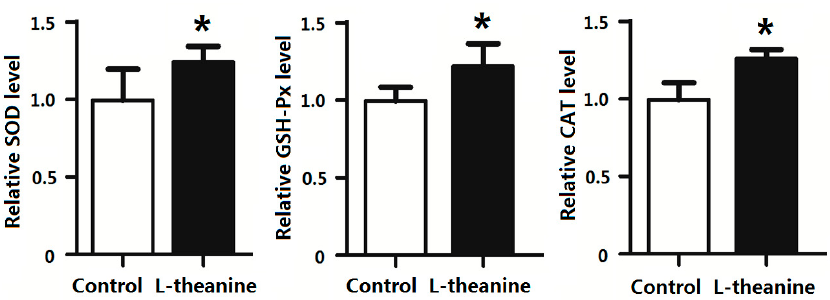
Figure 5. Effects of L -theanine on relative mRNA expression of cytokines in immune tissue. Note: Values are means ± SEM. vs. control group, * p ≤ 0.05.